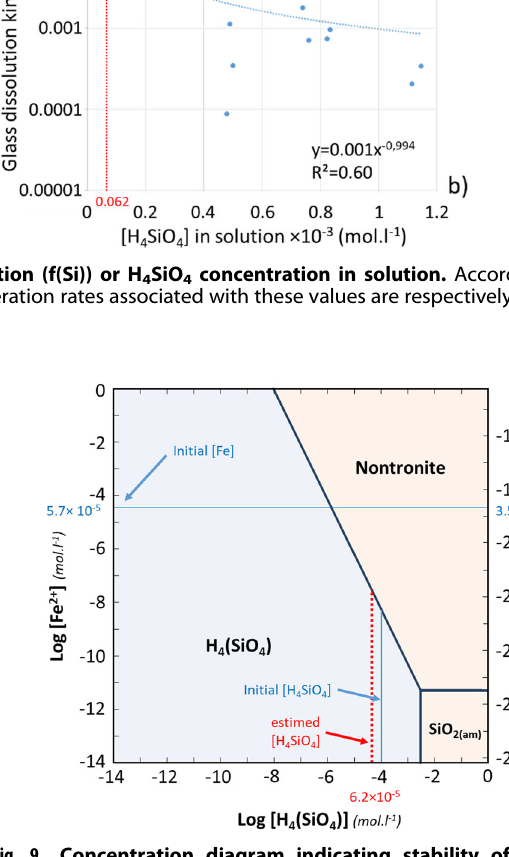
Fig. 9 Concentration diagram indicating stability of the main phases in the altered glass/iron/claystone system at 50 °C. Eh = − 0.14 V vs. SHE and pH = 6.86 at atmospheric pressure. In blue dissolved species, and in yellow stability domains of nontronite and amorphous silica (SiO 2(am) ). Blue lines present initial concentration of Fe and H 4 SiO 4 in solution. Red line shows the concentration of H 4 SiO 4 estimated in solution from Fig.